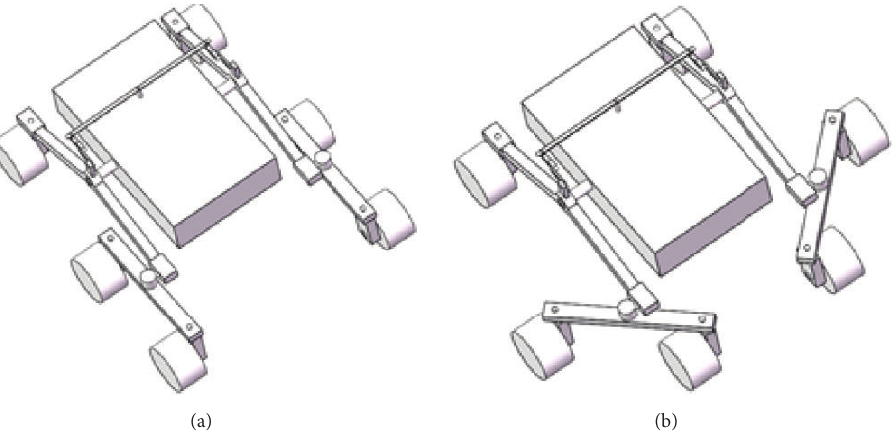
Figure 2: The two models of rocker-bogie suspension configurations: (a) original configuration and (b) high-speed traversal